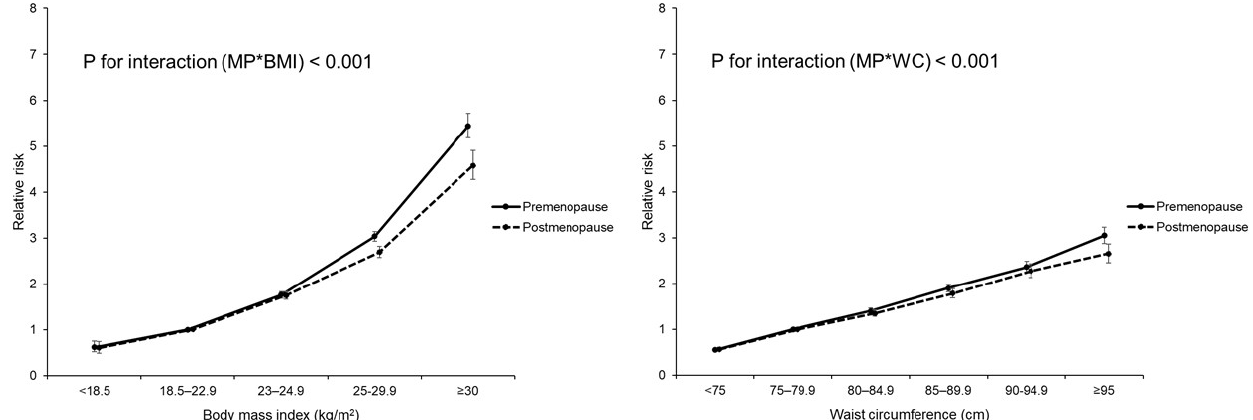
Figure 4. Diabetes incidence according to (A) body mass index and (B) waist circumference by menopausal status in 45– 55-year-old women.